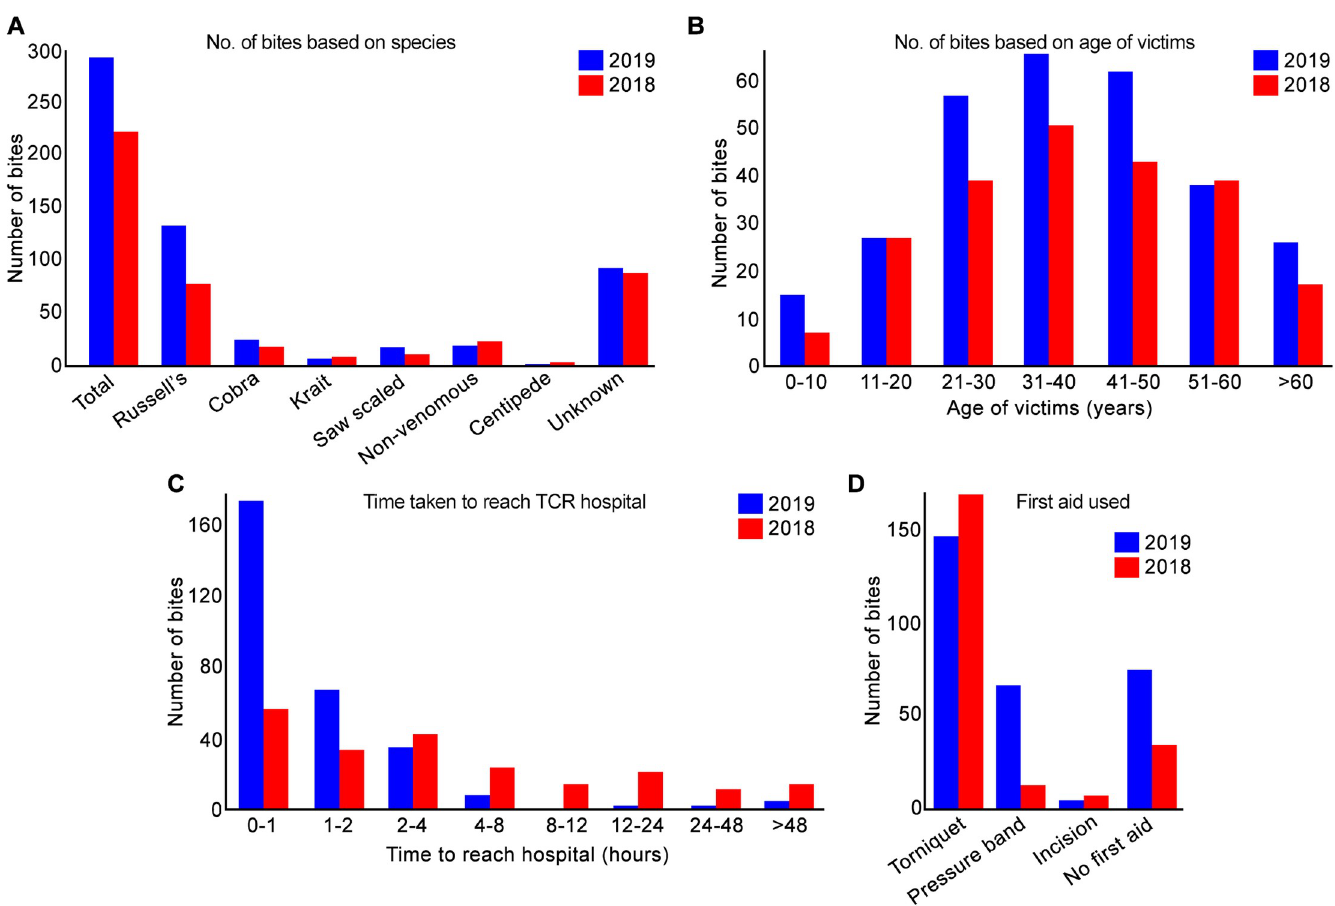
Fig 6. Evaluation of patient data from an SBE referral hospital. A , the total number of victims admitted into the study hospital in 2019 (blue) and 2018 (red), and classification of numbers based on the offending snake species. The total number of bite victims admitted in 2019 was significantly (X 2 = 8.9, df = 1, p = 0.003) higher than those admitted in 2018. The number of bites based on snake species was not (p = 0.098) significantly different between 2018 and 2019 as determined by the Fisher’s Exact Test for Count Data with simulated p-value (based on 10,000 replicates). B , age-wise classification of total number of victims admitted in the hospital in 2019 and 2018. The number of victims in age-wise categories was not (X 2 = 4.6, df = 6, p = 0.593) different in 2019 compared to 2018. C , the time taken to reach the hospital following bites. Here, the number of victims admitted within 2 hours in 2019 was significantly increased compared to 2018, while in other categories it was significantly reduced in 2019 (X 2 = 119.2, df = 7, p < 0.001). D , the number of people used (or not used) first aid measures. In 2019, the number of victims received no first aid or applied pressure bandage was significantly increased while the number using a tourniquet significantly reduced compared to 2018 data as calculated using Fisher’s Exact Test for Count Data with simulated p < 0.001, based on 10,000